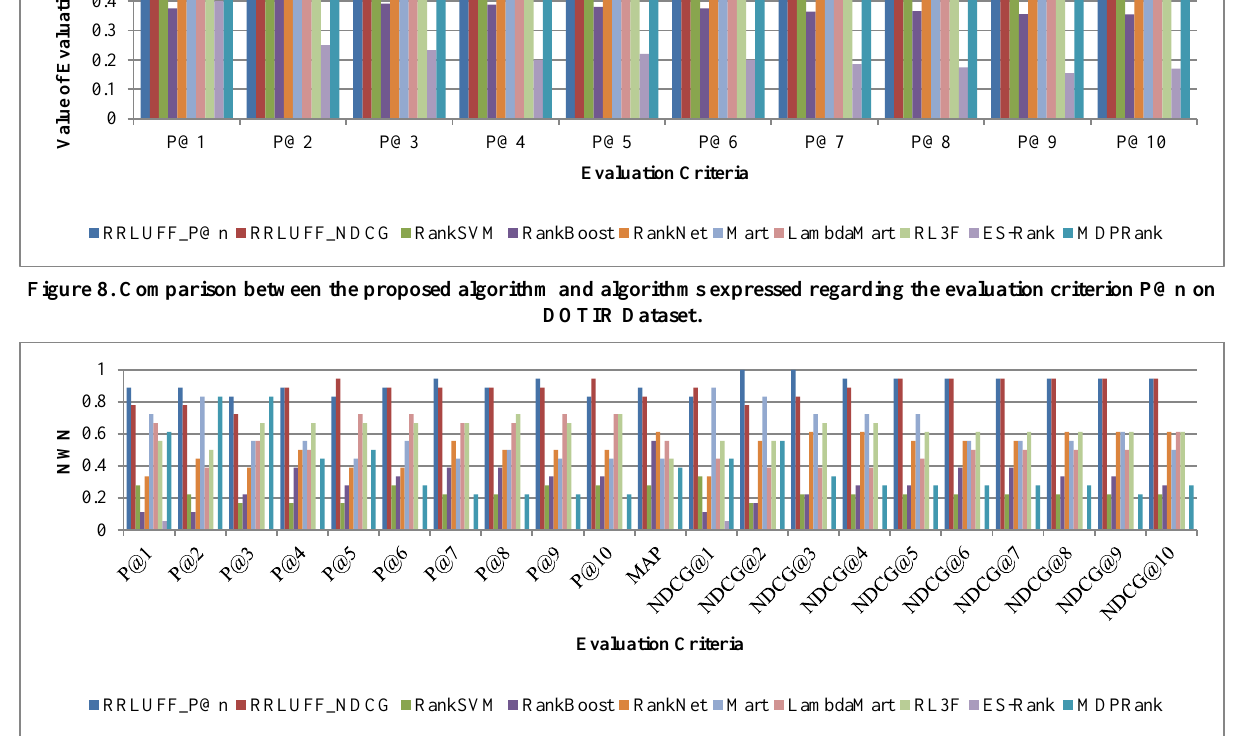
Figure 9. Comparing between the proposed method and Relevant Expressed Methods with Respect to Evaluation Criteria of NWN on OHSUMED and DOTIR